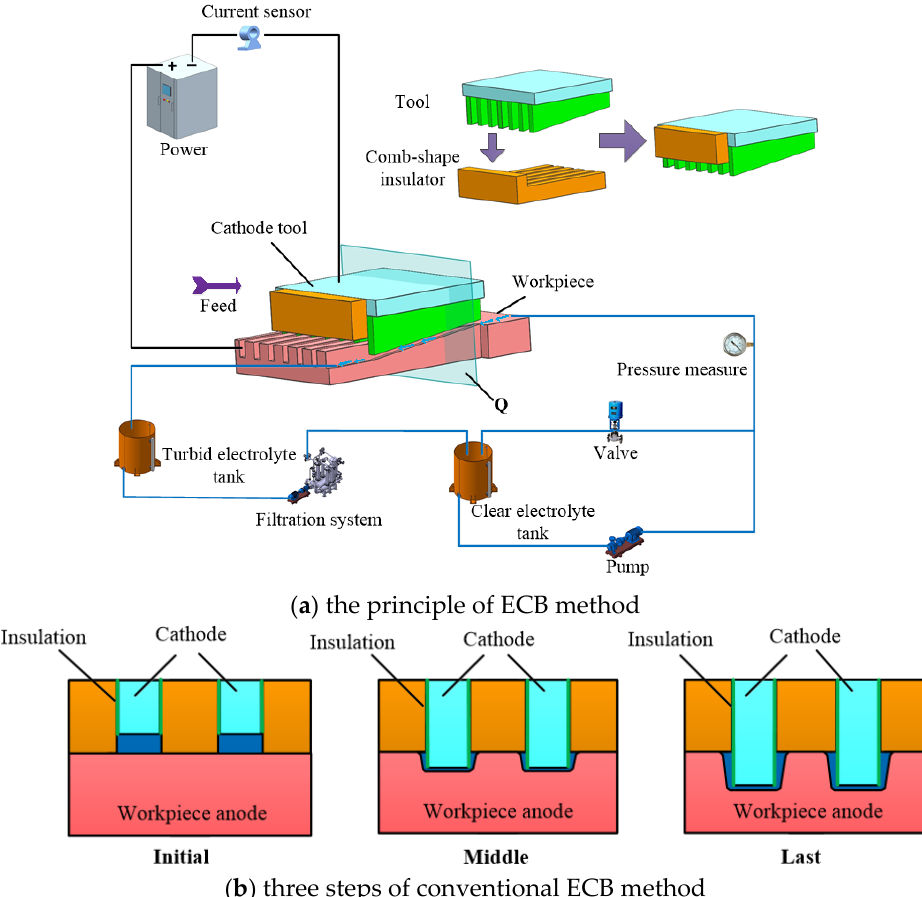
Figure 1. Schematic diagram of conventional ECB method for micro multi-grooves.